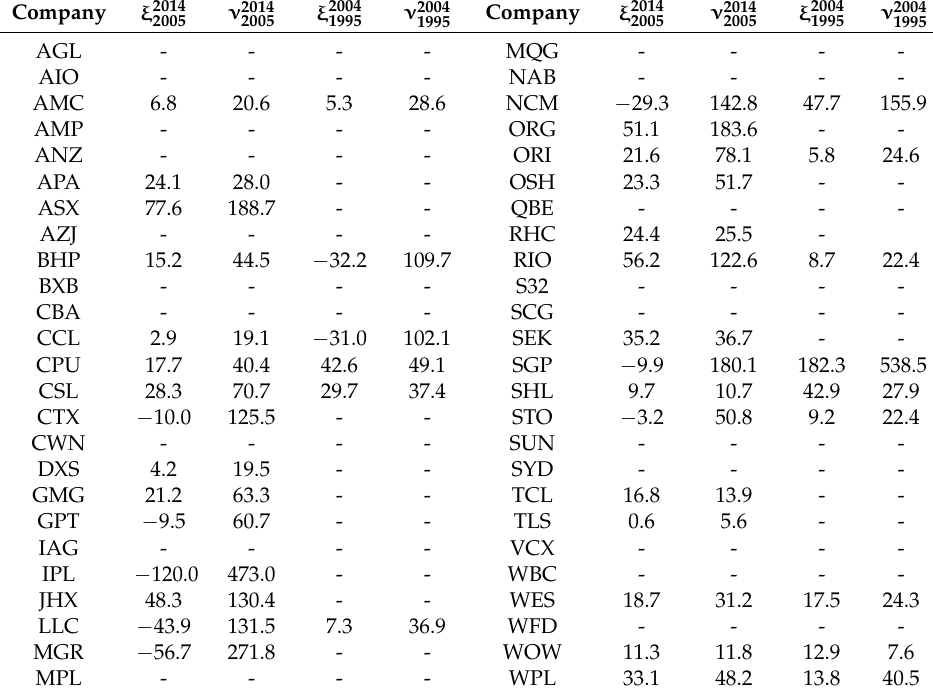
Table A9. Estimated parameters ξ ( % ) and ν ( % ) , for each company of ASX50 index.